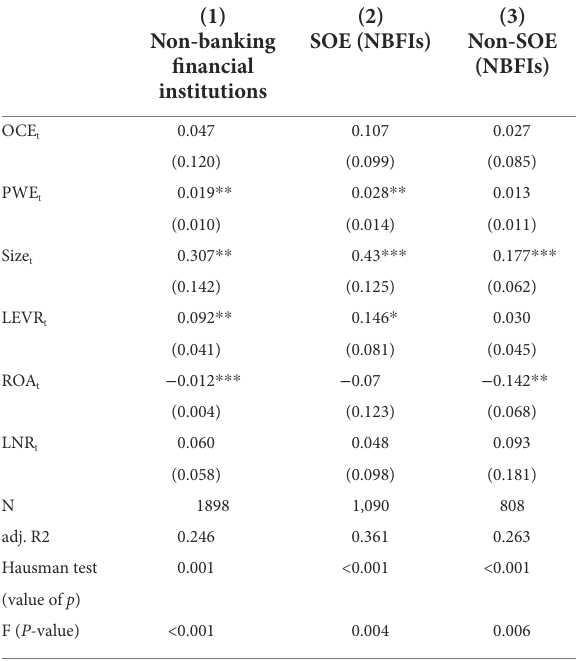
TABLE 3 Regression analysis for non-bank financial institutions (NBFIs). Dependent variable: systemic risk ( CoVaR ∆